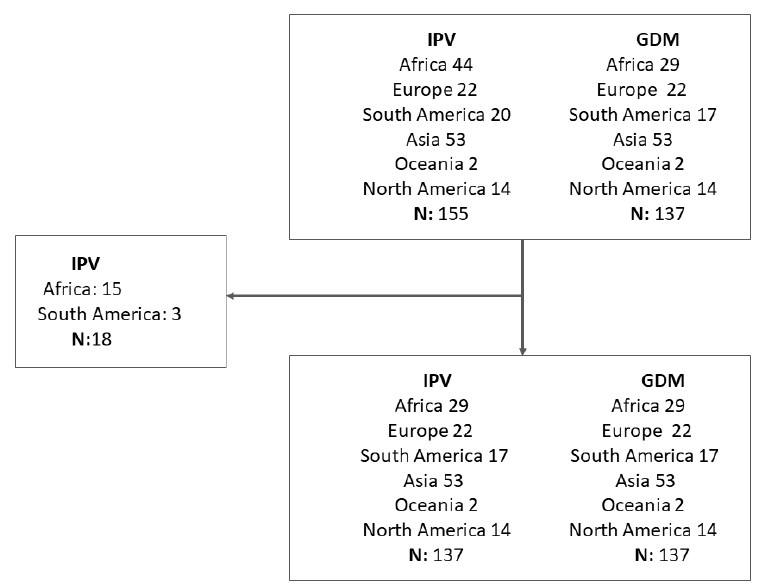
Figure 1. Flowchart of the prevalence studies of intimate partner violence (IPV) during pregnancy and gestational diabetes mellitus (GMD) included in the author gender study. Table 1. Characteristics of intimate partner violence (IPV) during pregnancy and gestational diabetes mellitus (GDM) prevalence studies included in the author gender